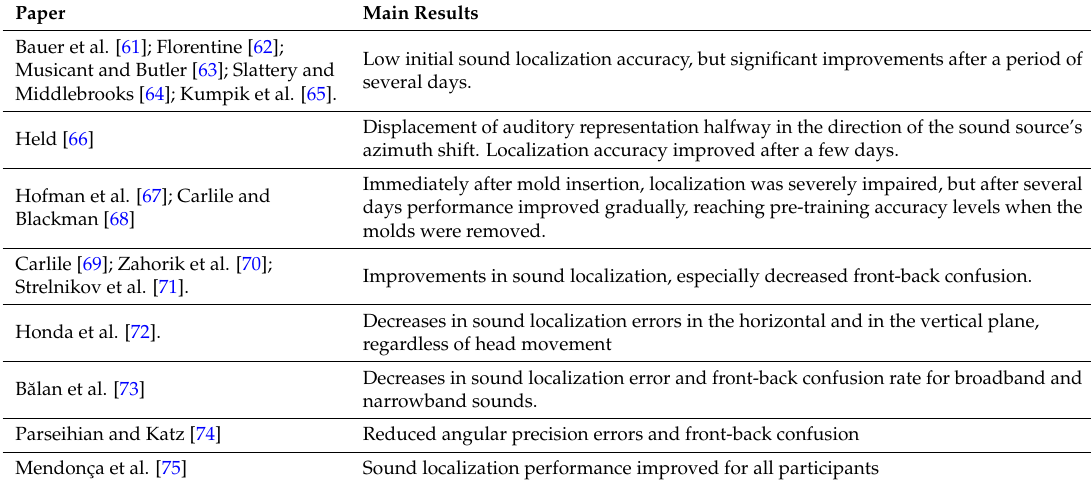
Table 4. Overview of the results reviewed in Section 5 (training sound